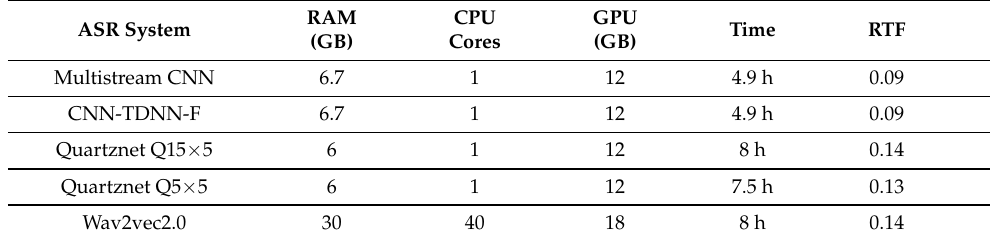
Table 6. Processing time and computational resources needed by each submitted system in terms of RAM memory, CPU cores, GPU memory, decoding time and Real-Time Factor (RTF). RAM ASR System